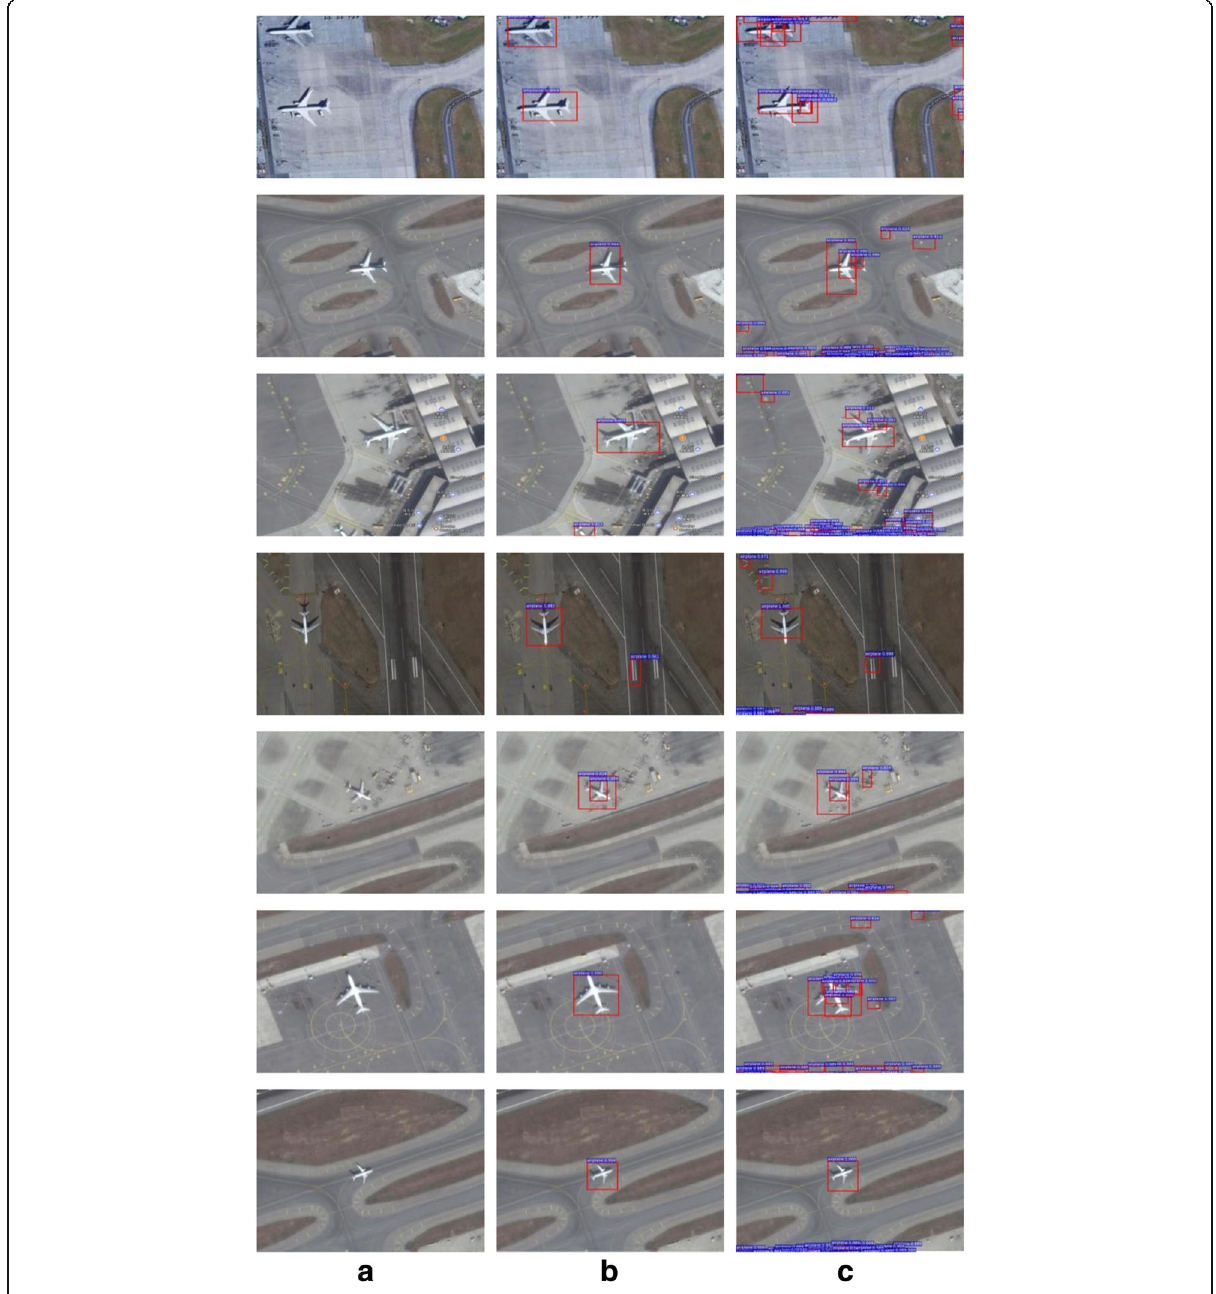
Fig. 9 Results of different number of negative samples. a Original image. b 400 negative samples. c 200 negative